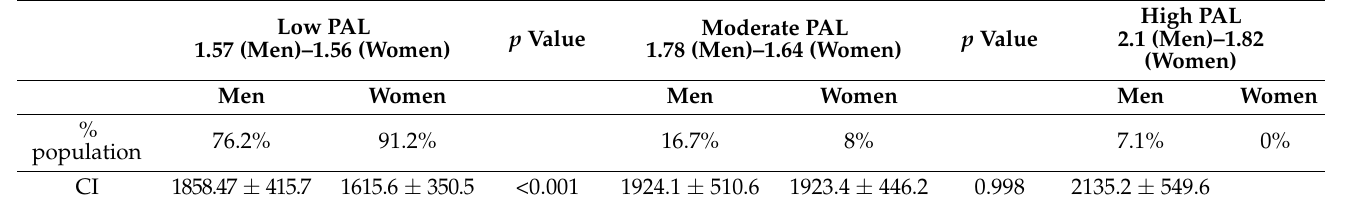
Table 6. Mean calorie intake (CI) according to the physical activity level (PAL) of patients with FSHD. Low PAL 1.57 (Men)–1.56